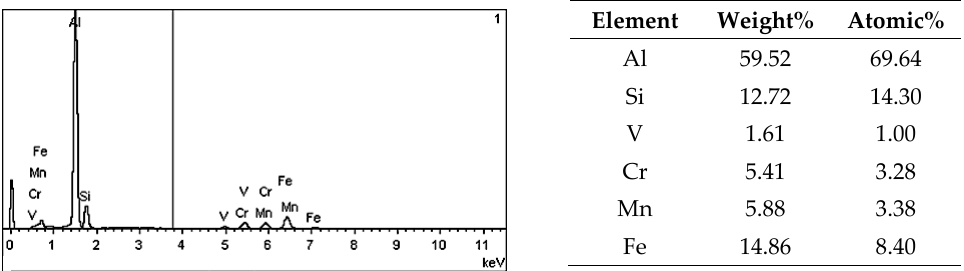
Figure 6. EDS diagram and chemical composition at point no. 1 of Figure 5.